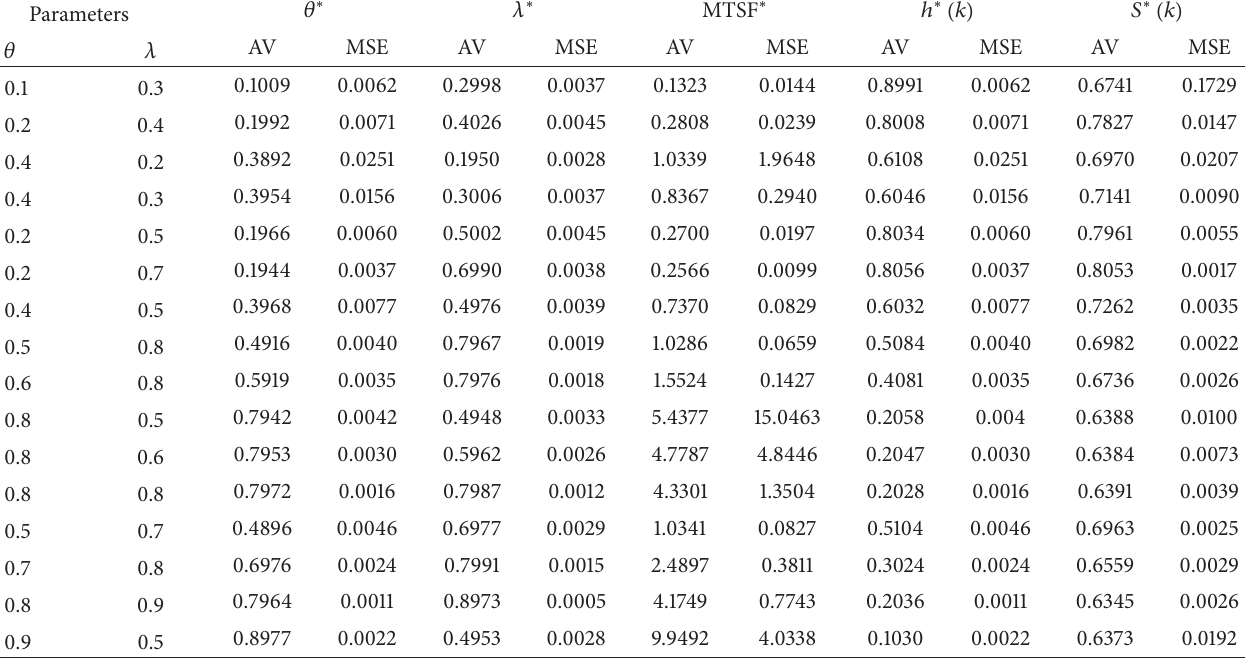
Table 9: Bayes estimates under SELF & noninformative